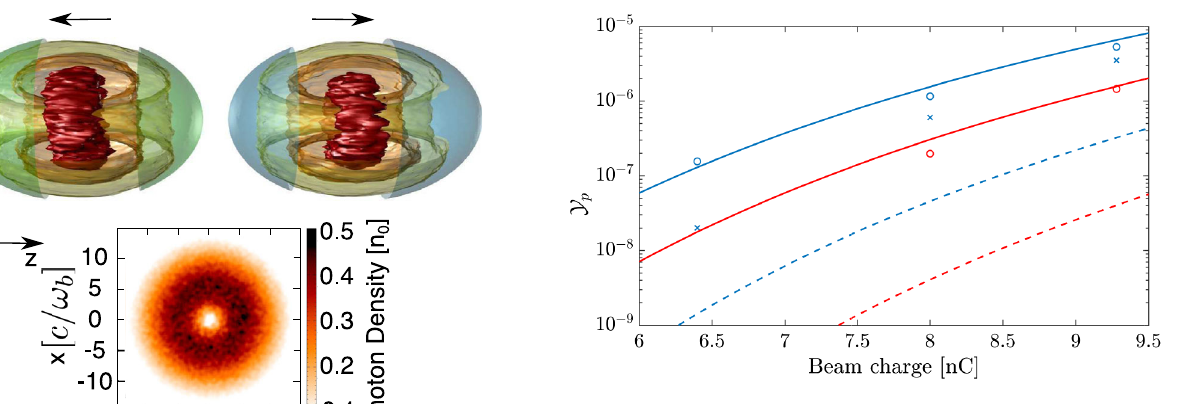
FIG. 3. Yield of the secondary pairs for two colliding beams 3 μ m length, for E ¼ 25 , with σ 0 ¼ 1 μ m spot size and σ z ¼ 30 GeV energy (red and blue, respectively), with the dashed line for the uniform averaged field model [5], OSIRIS simulation results represented by ( ∘ ), and the solid line representing Eq. (5). The uniform average field model underestimates sig- nificantly the pair yield. The OSIRIS simulations for elliptic 2 . 25 ) are denoted by = σ beams ( σ x y ¼